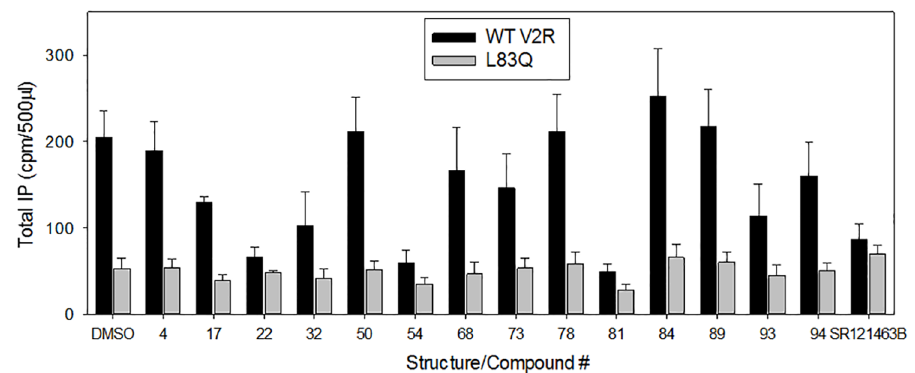
Fig 7. Rescue of IP production by WT and mutant-expressing HeLa cells by various pharmacoperones. Transiently transfected HeLa cells containinga total of 100 ng cDNA / 0.125 ml of hWT V2R or the L83Q mutant were treated with different pharmacoperones(10 μ M, or #50 utilized at 1 μ M) to show if the rescuedL83Q mutant is coupledto Gq (IP). The cells were incubatedwith the pharmacoperones for 18 h with 4 μ Ci/ml 3 H-inositolfor “preloading” IP pathway, then washed and stimulatedwith 1 μ M vasopressin for 2 h and IP response was measured. DMSO (vehicle)is a negative control that does not rescue the mutant and SR121463B is a known pharmacoperonefor the L83Q mutant. The results shown in the figure are from at least 3 independent experiments performed in quadruplicate(n = 3 ± SEM).